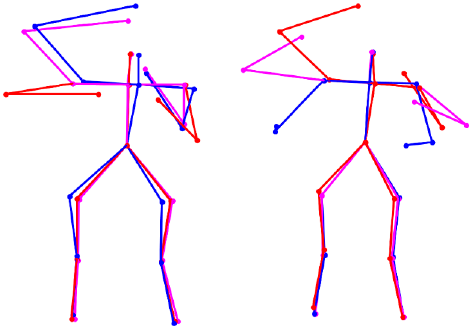
Figure 4. Visualization of two atomic motions of the action “wearing contact lenses” in CAD-60 dataset. The three time-ordered feature vectors are visualized as the red, magenta, and blue skeleton, respectively.